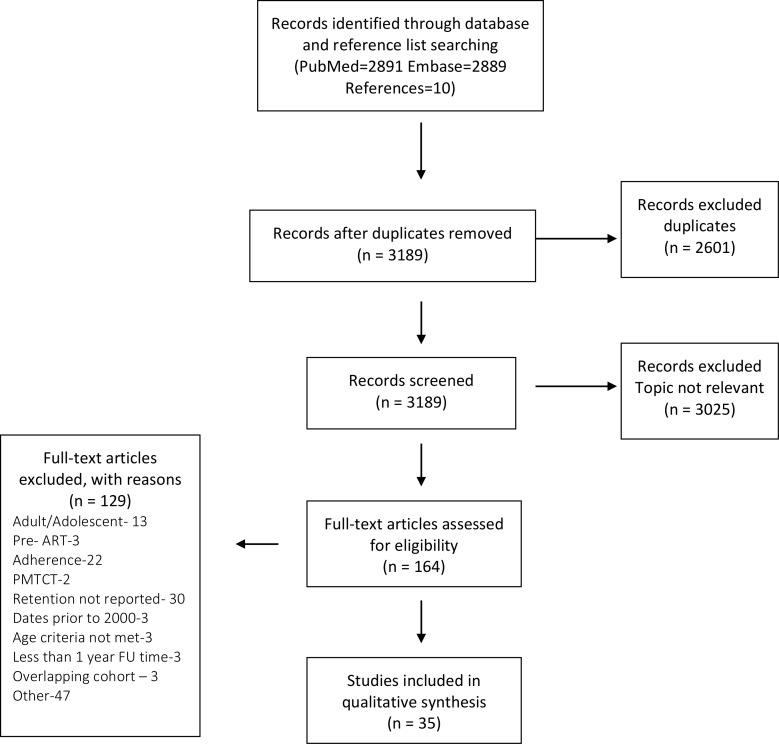
Identification and selection of studies.Fig 1 shows the studies identified and reasons for inclusion or exclusion.